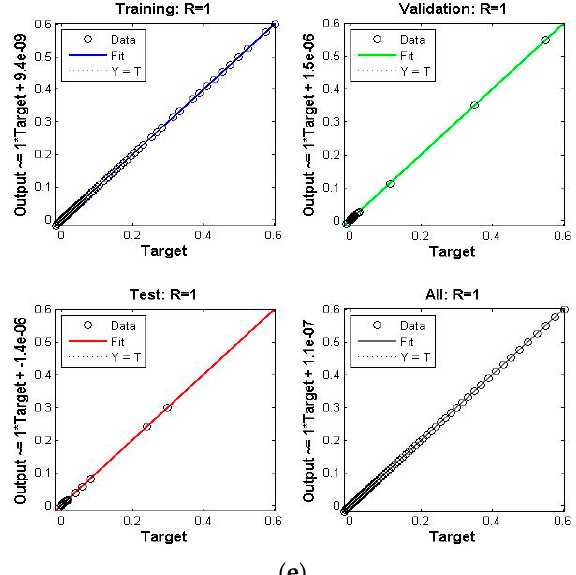
Figure 9. Scenario VI Case I of TD-PNFM. ( a ) MSE Results: Scenario VI Case I; ( b ) Transition state: Scenario VI Case I; ( c ) Fitness: Scenario VI Case I; ( d ) Error Histogram: Scenario VI Case I; ( e ) regression: Scenario VI Case I. Table 2. Outcomes of TLM-BANN of TD-PNFM.